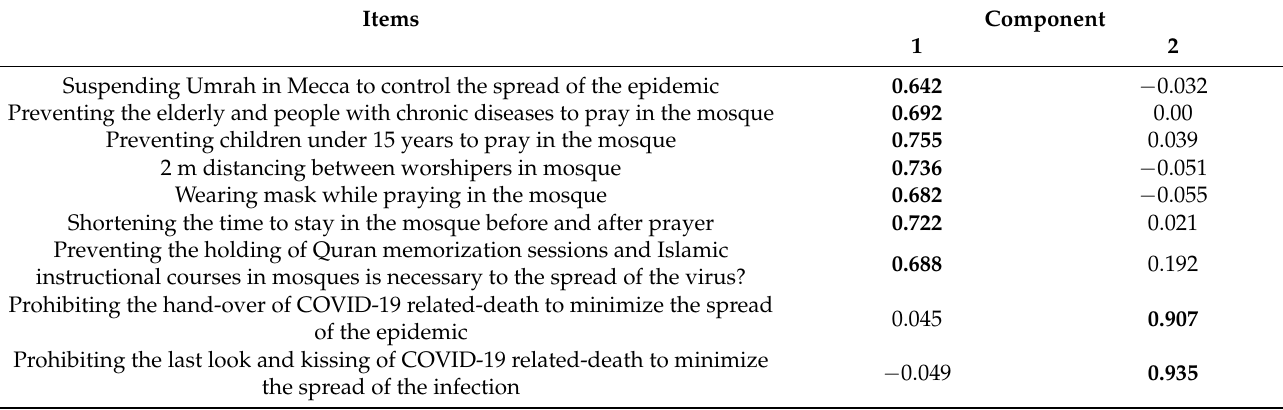
Table 6. Rotated Component Matrix of Islamic attitudes among study population in KSA.